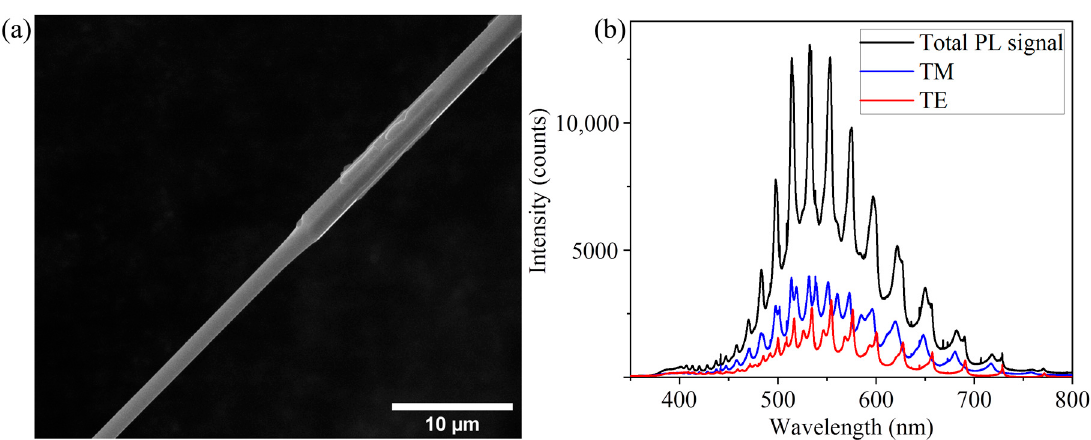
Figure 5. ( a ) SEM image and ( b ) µ -PL spectra for all the polarization conditions of the transition